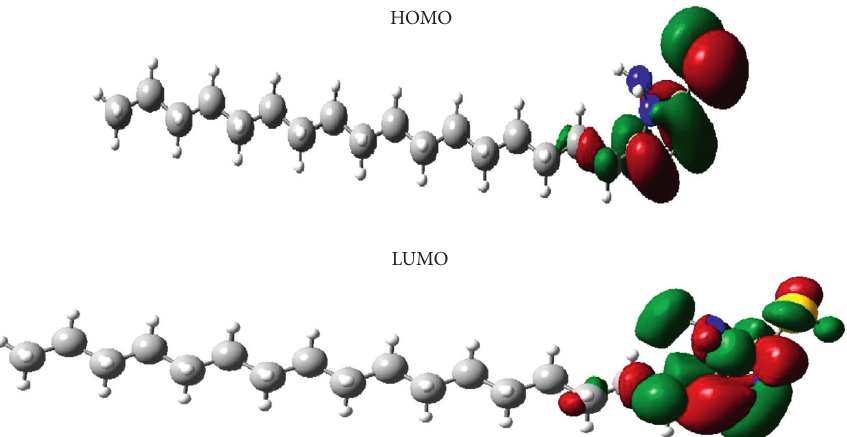
Figure 3: HOMO and LUMO patterns of triazole ligand.